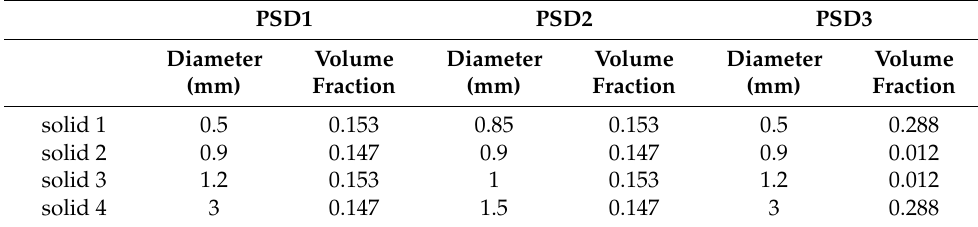
Figure 8. Synthesized particle size distribution curves with D 50 = 0.9 mm to examine the effect of particle size distribution. Table 3. The diameter and volume fraction allocated for particle size distributions PSD1, PSD2, and PSD3 for overall porosity of 0.4.